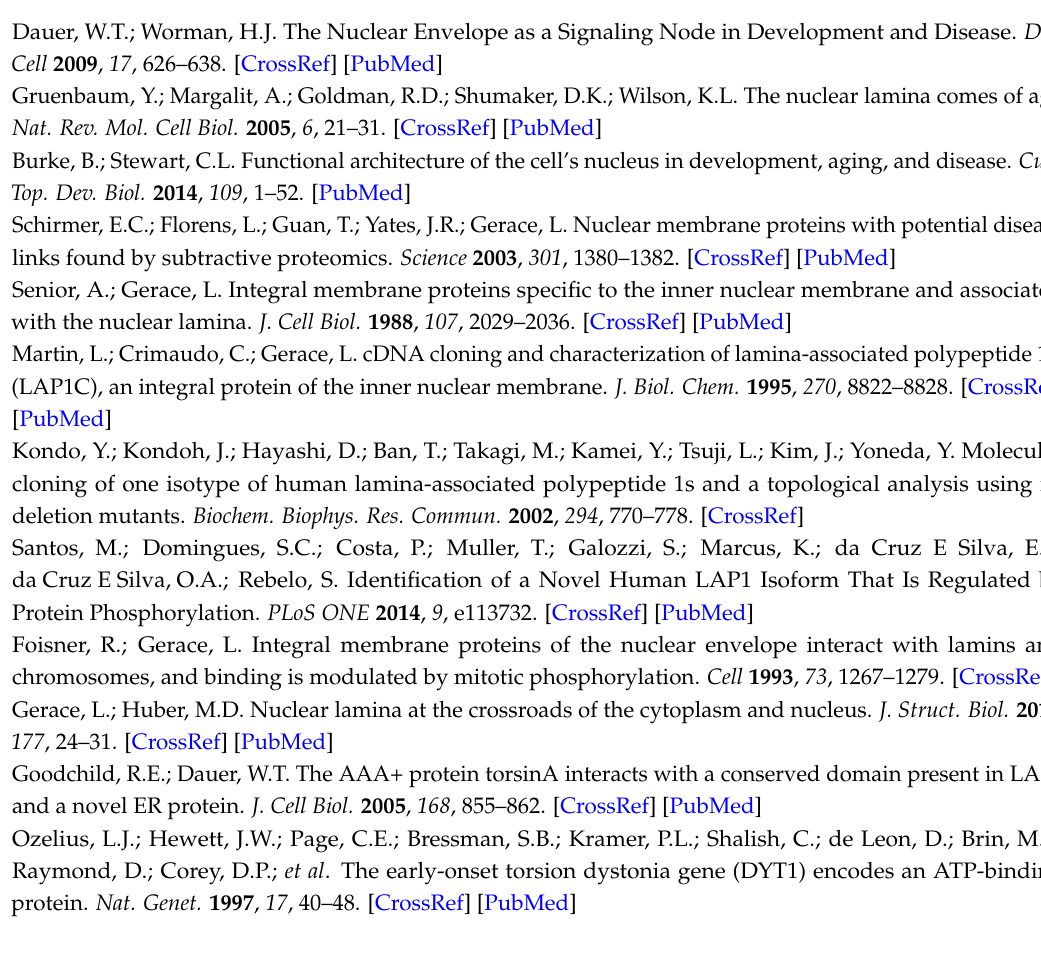
Supplementary Materials: Figure S1: Significantly enriched Gene Ontology terms from the LAP1 interaction network concerning Biological Processes. Figure S2: Significantly enriched Gene Ontology terms from the LAP1 interaction network concerning Cell Components. Figure S3: Top Upstream Regulators of the LAP1 interactome. Figure S4: Molecular and cellular functions for LAP1 interactors. Figure S5: Merged molecular and cellular functions associated with LAP1